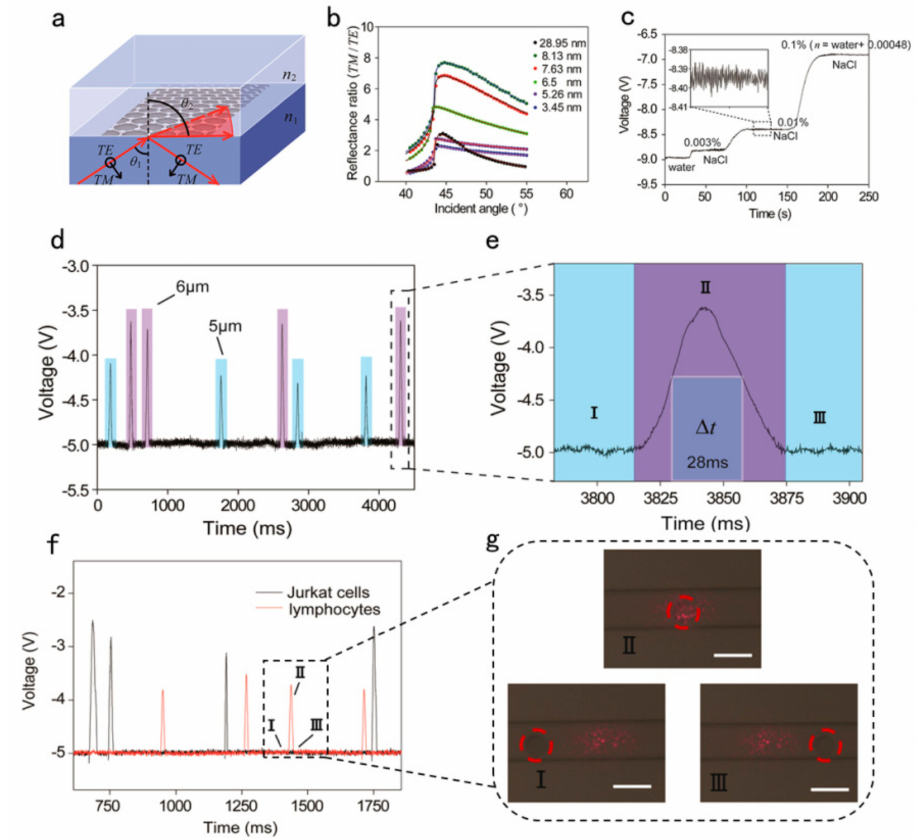
Figure 6. ( a ) Schematic of the enhanced sensitivity and resolution of refractive index (RI) sensing of high temperature reduced graphene oxide (h-rGO). ( b ) Angle-dependent reflectance ratio (TM / TE) plots of di ff erent thicknesses of h-rGO. ( c ) Real-time signal of di ff erent ultralow concentrations of NaCl solution. ( d ) Discrete time-dependent changes in voltage that correspond to PS microspheres as they roll across the h-rGO detection window. The light blue and light purple areas represent the discrete voltage signals of 5 and 6 µ m PS microspheres, respectively. ( e ) Entire sensing process for a single PS microsphere detected by the graphene-based optical single-cell sensor (GSOCS) in which ∆ t represents the time changes for a PS microsphere that rolls across the h-rGO detection window. ( f ) Discrete time-dependent changes in voltage that correspond to a single lymphocyte or Jurkat cell as it rolls across the detection window. The black and red lines represent Jurkat cells and lymphocytes, respectively. ( g ) Microscopic images of the h-rGO detection window as lymphocytes roll across it. The scale bar is 15 µ m, and the height of microfluidic channel is approximately 9 µ m. Reproduced from [84] with permission of the American Chemical